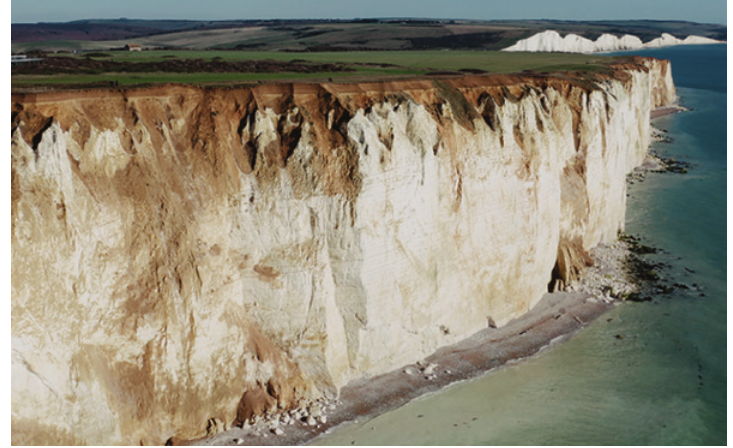
Figure 10 Seaford Head (Source: photograph by Chip